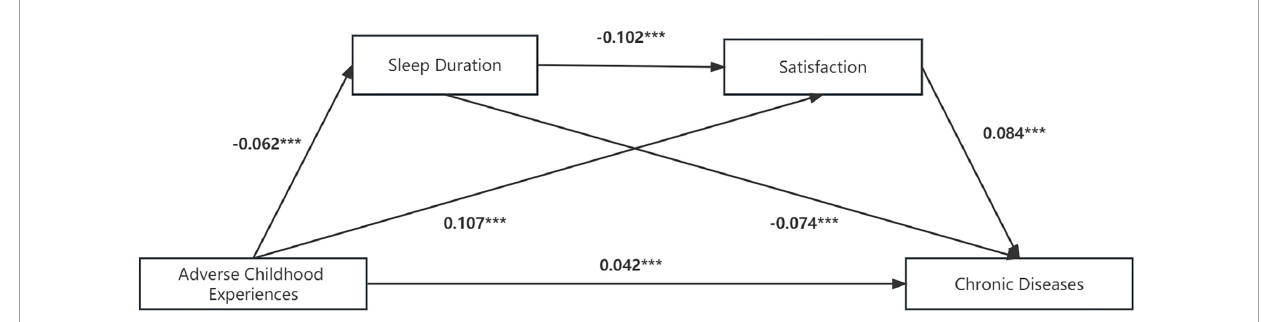
FIGURE4 Multiple mediation model between adverse childhood experiences and chronic diseases with sleep duration and life satisfaction as mediators. Path values are the path coefficients. *** P < 0.001.